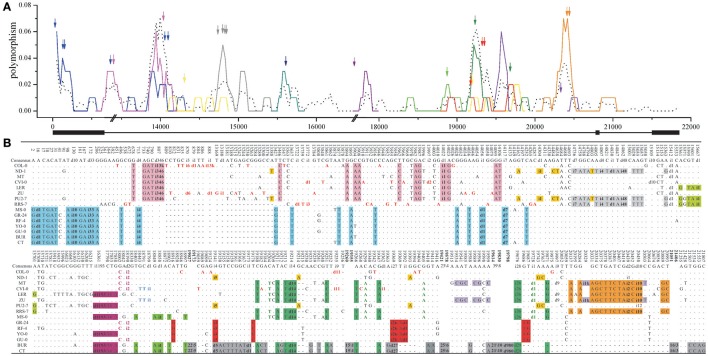
Sliding window analysis of the nucleotide diversity (A) and polymorphism (B) in long intergenic locus LI1. (A) The number (bp) on the horizontal axis represents the relative position in the long-intergenic sequences at each locus. The different-colored lines represent the sliding windows of the dimorphic diversity (dxy), and the dotted-black line stands for nucleotide diversity (π). The double slash (//) indicates a large insertion in one accession. Indels are marked as arrows, and lack boxes represent coding regions. (B) The i33 or d14 stands for a 33-bp insertion or 14-bp deletion. The different colored mutations are various indel-linked substitutions. And the bolded numbers represent the omitted polymorphic sites as 20/4 (20 substitutions and four indels were omitted in the region between the bolded positions), for example.